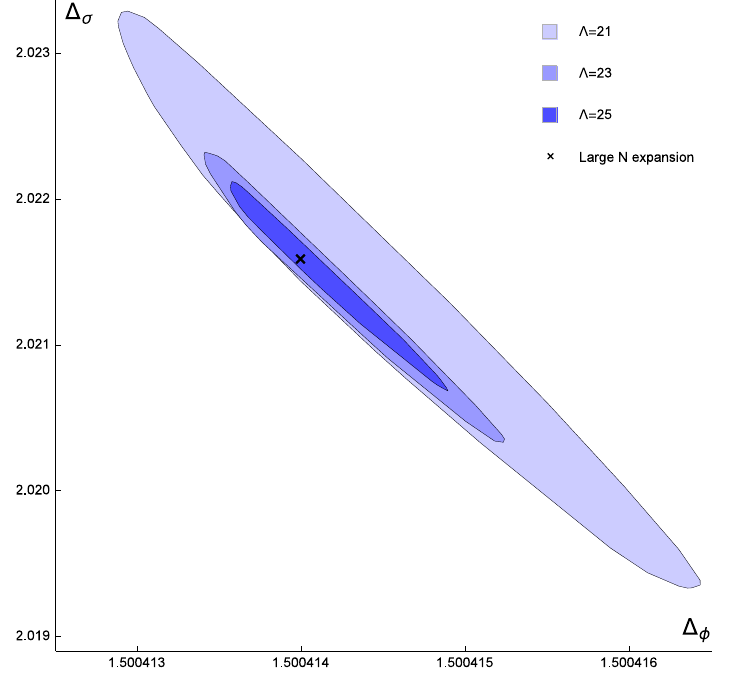
Figure 2 . Isolated regions for the conformal dimensions ((cid:1) (cid:30) ; (cid:1) (cid:27) ) in 5 D O (500) vector model. The light, medium and dark blue regions are corresponding to the results from multiple correlator conformal bootstrap with (cid:3) = 21 ; 23 ; 25, respectively. In the graph we have used the dimension gaps (cid:1) (cid:3) = 3 : 965 and (cid:1) (cid:3) = 5. The black cross denotes the prediction from large N S; 0 V; 0